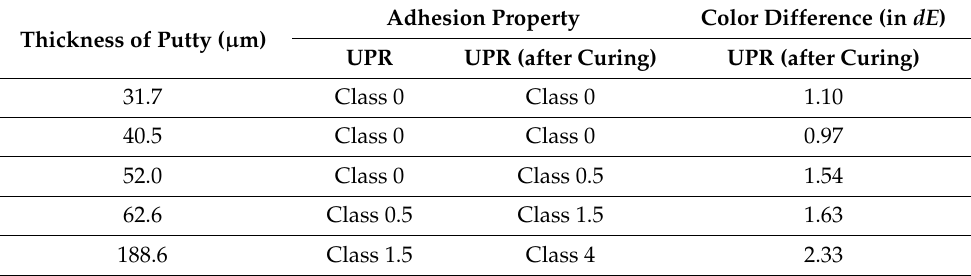
Table 3. Adhesion property and color difference of UPR-putty-treated